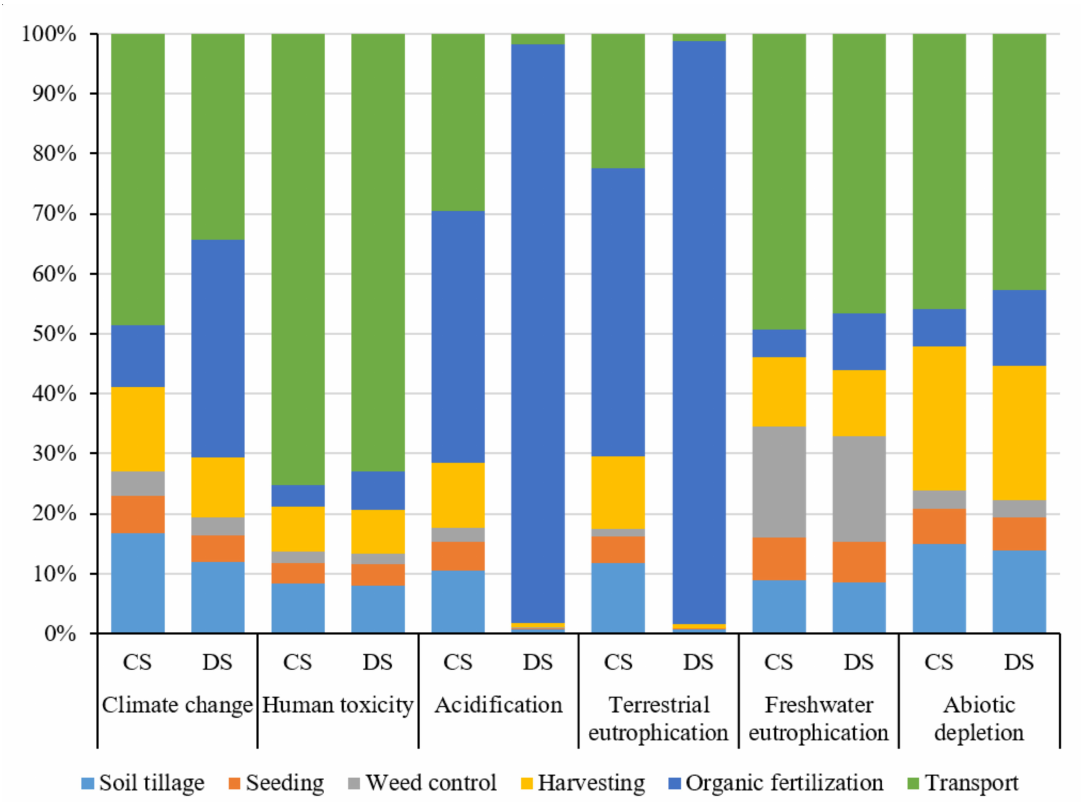
Figure 5. Relative contribution (%) to the environmental impacts categories of each process for the production of 1 t of CU of the crop rotation camelina-barley-camelina fertilized with dewatered sludge (DS) and composted sludge